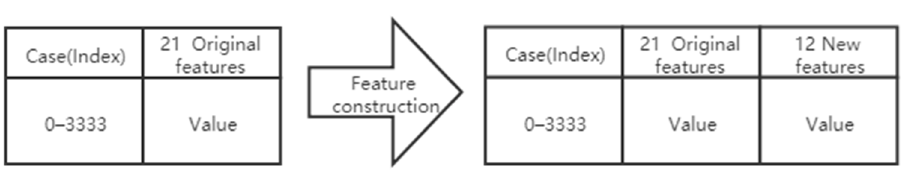
Figure 6. The new dataset after feature construction.